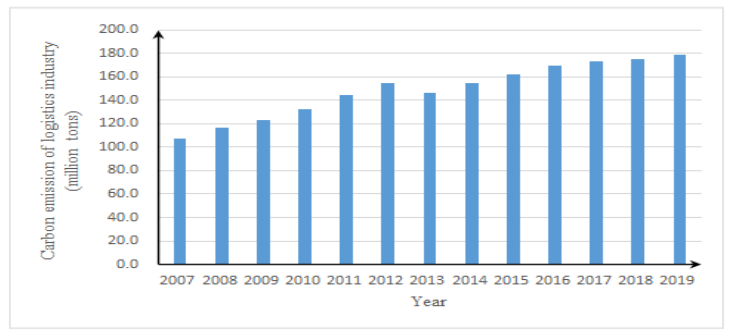
Figure 1. The carbon emissions of China’s logistics during 2007–2019.